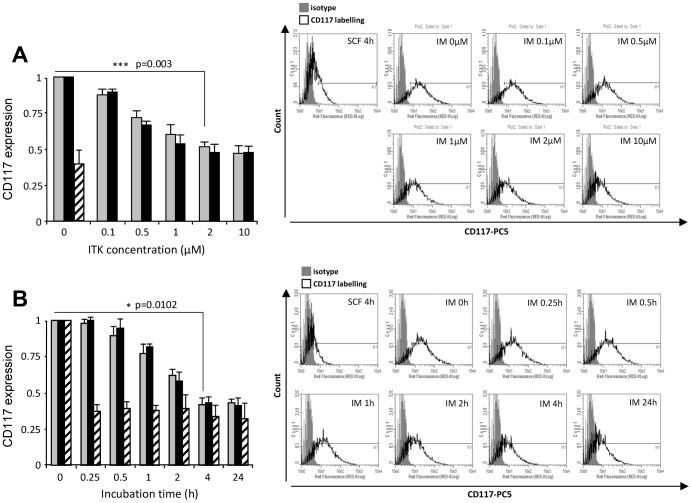
Imatinib or masitinib decreases cell surface expression of mature c-Kit in UT-7/Epo cell line.
A. Dose-dependent inhibition of c-Kit expression by TKI. Cell surface expression of c-Kit. UT-7/Epo cells were incubated with SCF 50 ng/ml for 10 min (hatched bars) or indicated concentrations of imatinib (IM) (grey bars) or masitinib (MA) (black bars) for 4 h. B. Kinetic of c-Kit down-regulation by TKI. UT-7/Epo cells were incubated with 2 µM IM (grey bars) or MA (black bars) or 50 ng/ml SCF (hatched bars) for indicated times. C-Kit cell surface expression was determined by flow cytometry. Results were expressed as ratios of median fluorescence intensity (RFI), and the values were normalized to untreated cells. Results are the mean of at least three independent experiments.